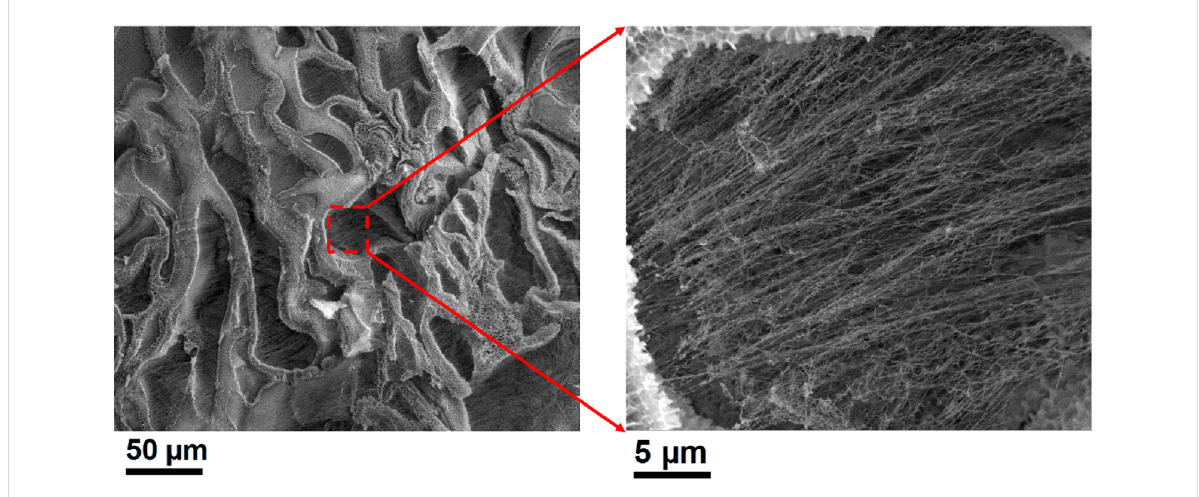
Figure 2: H3AH3 ELR hydrogel morphology observed by SEM. A high magnification image of the red framed area is shown in the micrograph on the right.